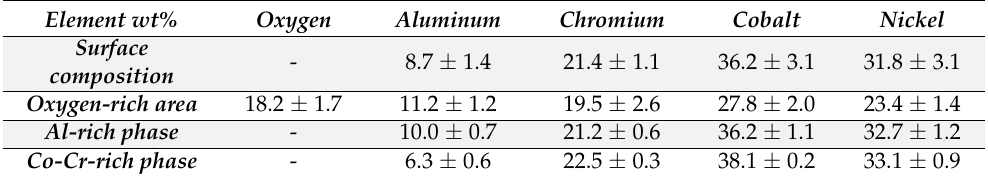
Table 4. Energy dispersive spectrum analysis at CoNiCrAlY-coating sample.